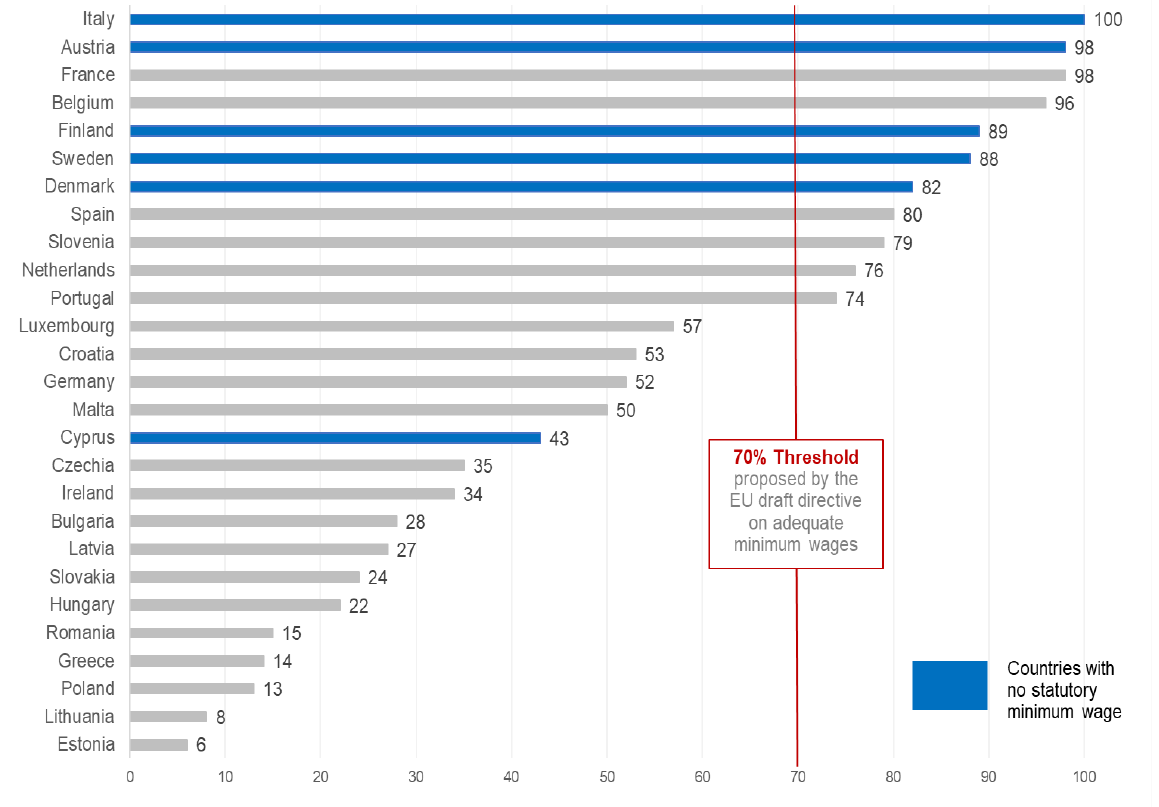
Figure 2: Collective bargaining coverage in EU countries, 2019* Workers covered by collective agreements in % to all workers eligible to collective bargaining